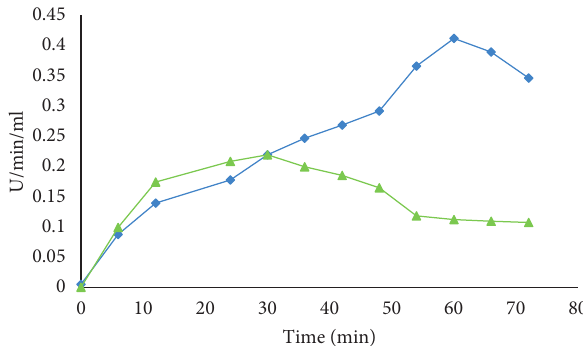
Figure 9: Storage inactivation at 4 ° C for B. licheniformis (blue) and B. cereus (green).